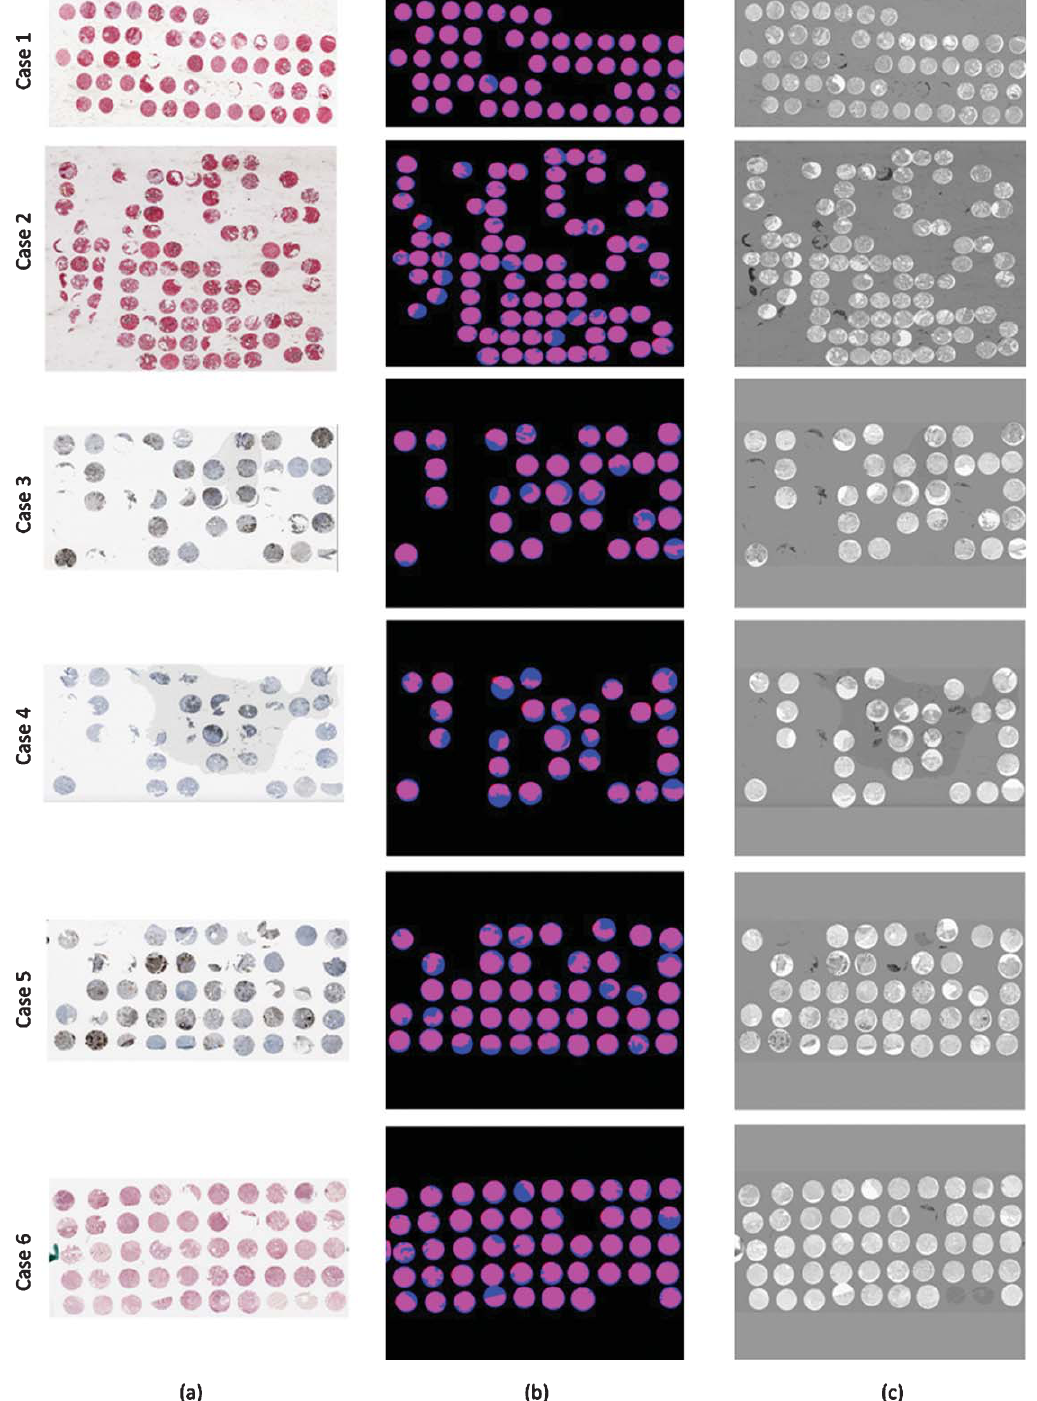
Fig. 5. (a–c). The application of our method to tissue microarray images. (a) Original TMA image. (b) Objects following morphology (Stage 4) overlaid against reconstructed circles (Stage 5). (c) Original image overlaid against reconstructed